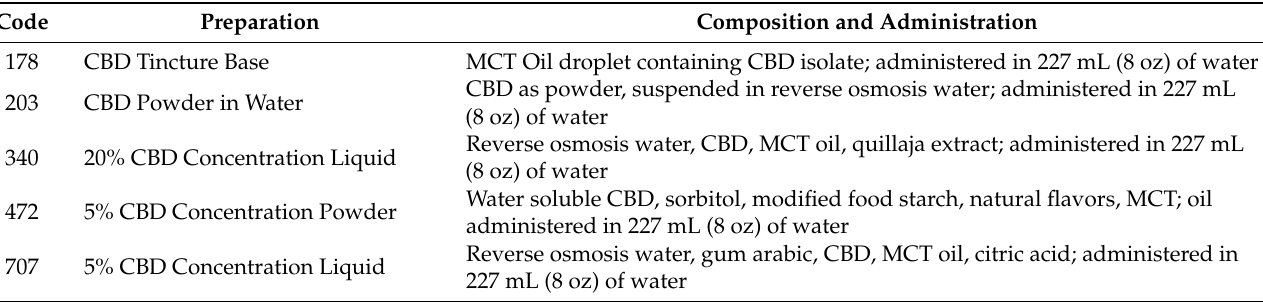
Table 2. Features of the cannabidiol (CBD) preparations.